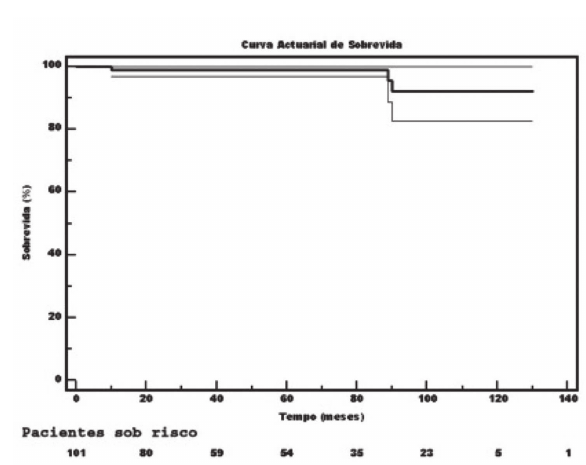
Fig. 2 – Curva actuarial de sobrevida com intervalo de confiança